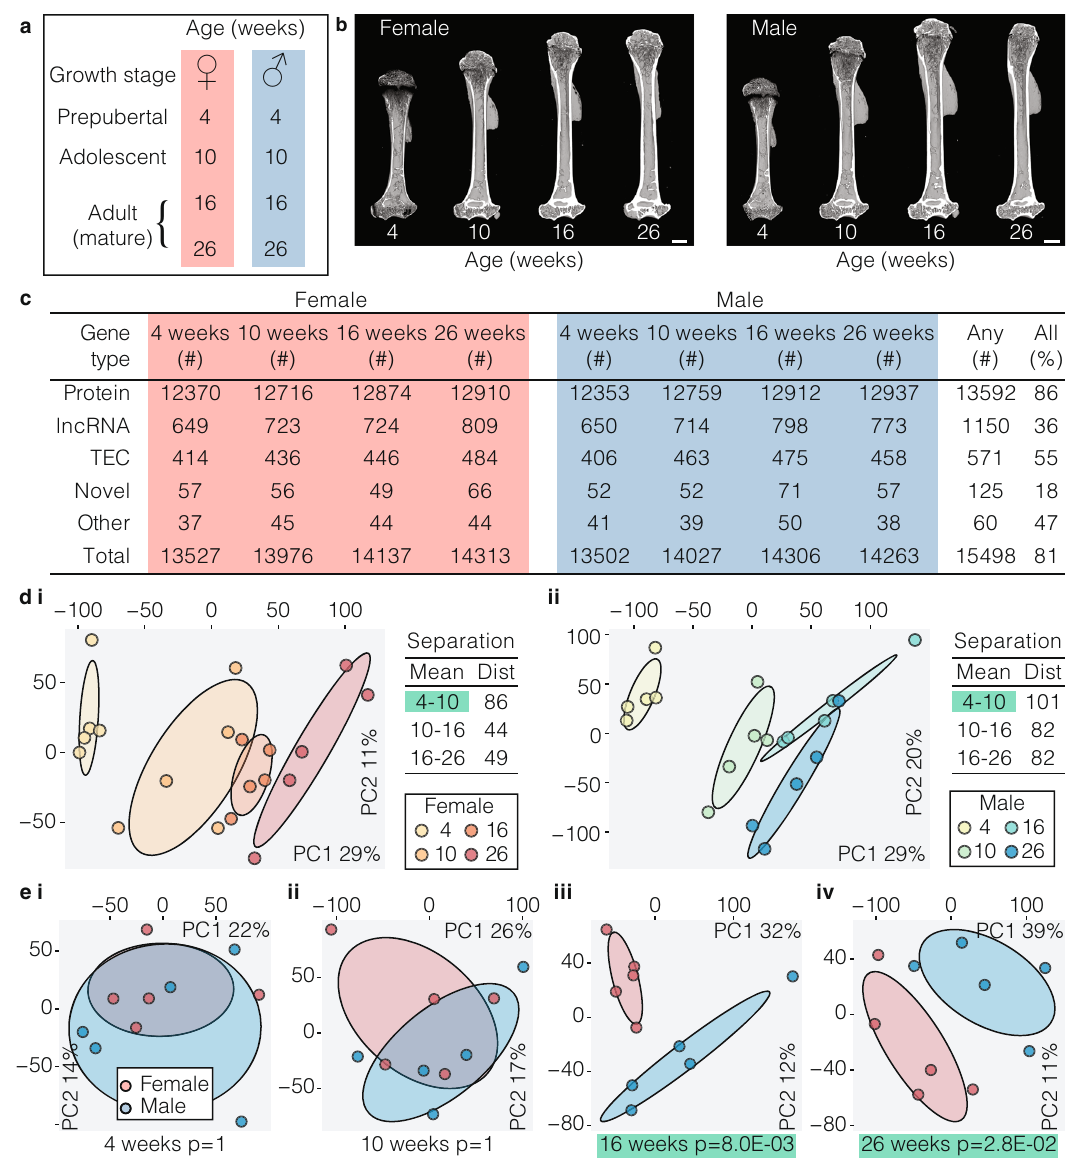
Fig. 2 The osteocyte transcriptome changes with sex and age. a Experimental design used to de fi ne the osteocyte transcriptome in each sex during skeletal maturation. b Representative micro-CT images of humeri from female and male mice at different ages. c The number of active genes and biotype composition of the osteocyte transcriptome at different ages in each sex. Any re fl ects the number of genes actively expressed in any ages or sexes, All re fl ects the percentage of genes active in any age or sex that are active in all ages and sexes. TEC = to be experimentally con fi rmed. d Principal component (PC) analysis of samples clustered by age in female (i) and male (ii) mice. The percentage of total variance explained by individual PCs is shown. Dots represent individual biological replicates and ellipses represent 50% con fi dence intervals for each age. Dist = Euclidean distance between cluster centroids (mean). P -values were calculated using Hotelling ’ s t -test (one-sided, Bonferroni adjusted), clusters with signi fi cant separation ( P < 0.05) between centroids are highlighted in green. e Principal component analysis of samples clustered from both sexes at 4 (i), 10 (ii), 16 (iii) and 26 (iv) weeks of age. The percentage of total variance explained by individual PCs is shown. Dots represent individual biological replicates and ellipses represent 50% con fi dence intervals for each sex. P -values were calculated using Hotelling ’ s t -test (one-sided, Bonferroni adjusted), clusters with signi fi cant separation ( P < 0.05) between centroids are highlighted in green.